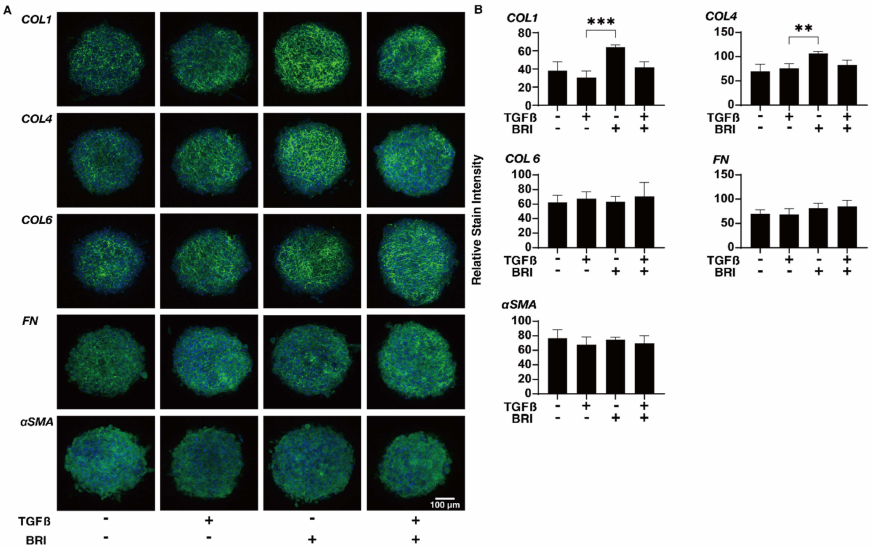
Figure 6. Effects of brimonidine (BRI) on the immunolabeling of ECM molecules in TGF- β 2-treated 3D HTM cells.The 3D-cultured HTM on day 6 were untreated (NT) or treated with 5 ng/mL TGF- β 2 (TGF β ) in the presence or absence of 10 µ M brimonidine (BRI) and were subjected to immunoflu- orescent labeling of ECMs, including COL1 , 4 , or 6 ; FN ; or a-SMA . Experiments were repeated in duplicate ( n = 10). Representative merged images with DAPI (blue) and anti-ECM images (green) are demonstrated (panel A, scale bar; 100 µ m). The staining intensity ratios relative to NT are plotted (panel B). “+” is reagents addition. “ − ” is reagents non-addition. Regarding the data, the mean ± standard error of the mean (SEM) are shown. ** p < 0.01, *** p < 0.005; ANOVA followed by a Tukey’s multiple comparison